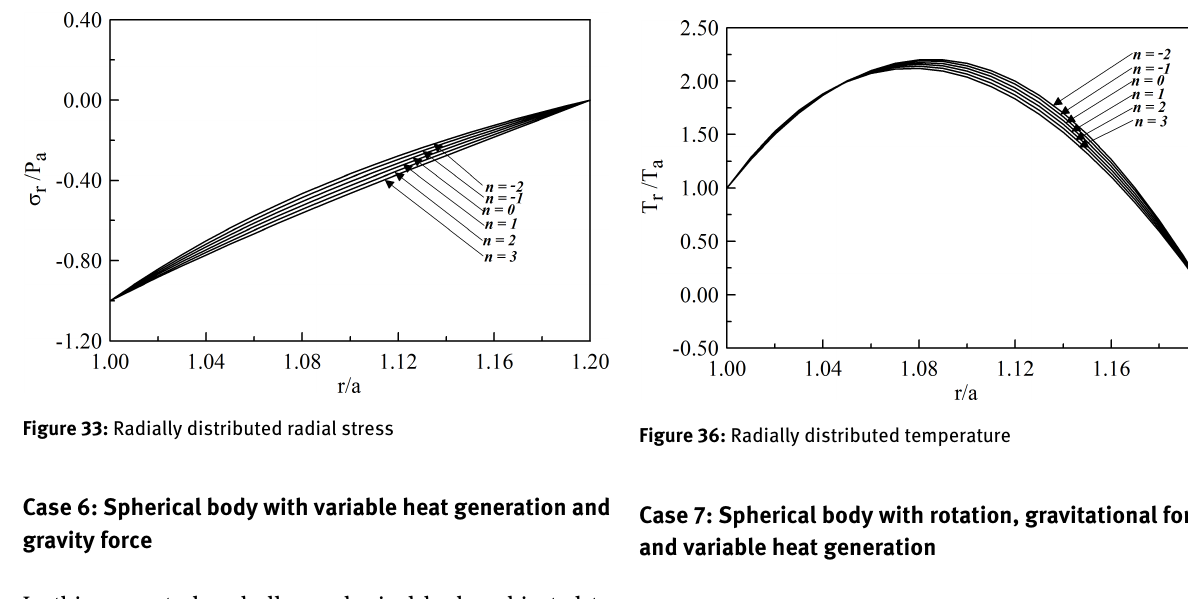
Figure 35: Radially distributed von-Mises stress